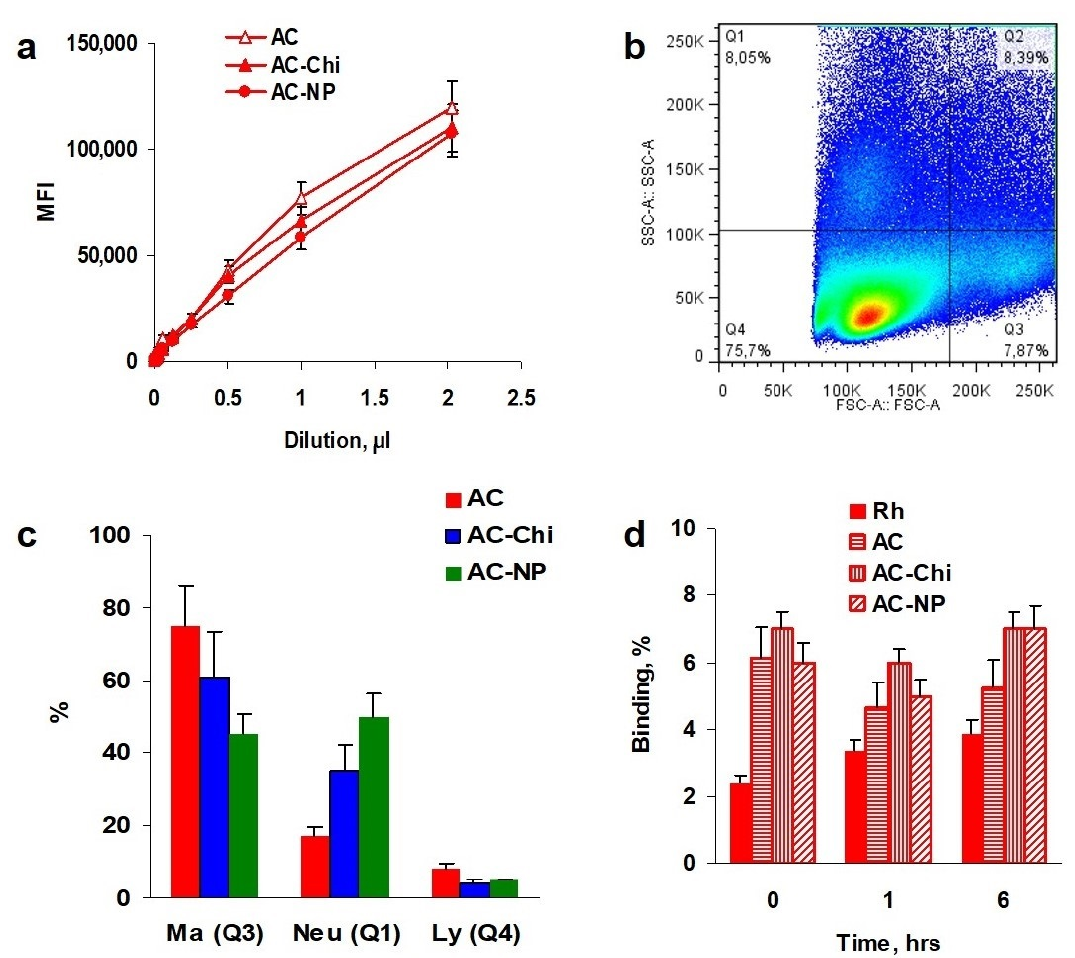
Figure 3. Binding of furano-allocolchicinoid 2 formulation to blood cells. ( a , b ) Calibration curves of rhodamine B labeled AC , AC-Chi , and AC-NPs . Ordinate corresponds to mean fluorescence intensity (MFI). ( b , c ) Furano-allocolchicinoid formulations were incubated 1 h with human whole blood and analyzed by flow cytometry. A representative dot plot of human blood cells ( a ). Lymphocytes (Ly), macrophages (Ma), and neutrophils (Neu) locate in quadrants Q4, Q3, and Q1, respectively. Percentages of Ma, Neu, and Ly after in vitro 1 h binding. ( d ) Percentage of rhodamine B and furano-allocolchicinoid formulations bound to mouse leukocytes when injected in vivo and extracted at 0.1, 1, and 6 h post injection.